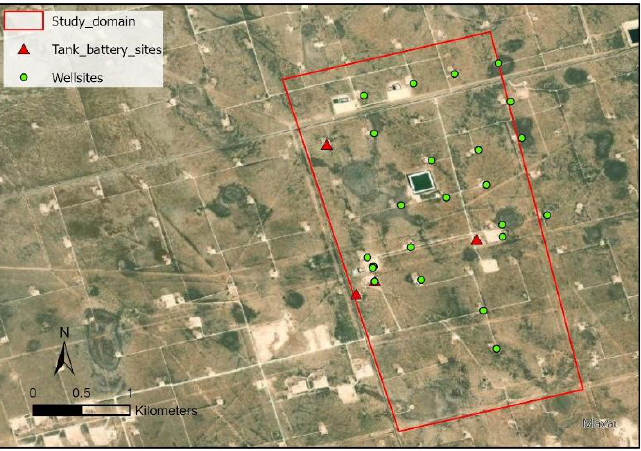
Figure 1. Satellite image of the modeling domain in the Midland Basin. Emissions were simulated at the 22 well sites and 4 tank battery sites shown on the map.